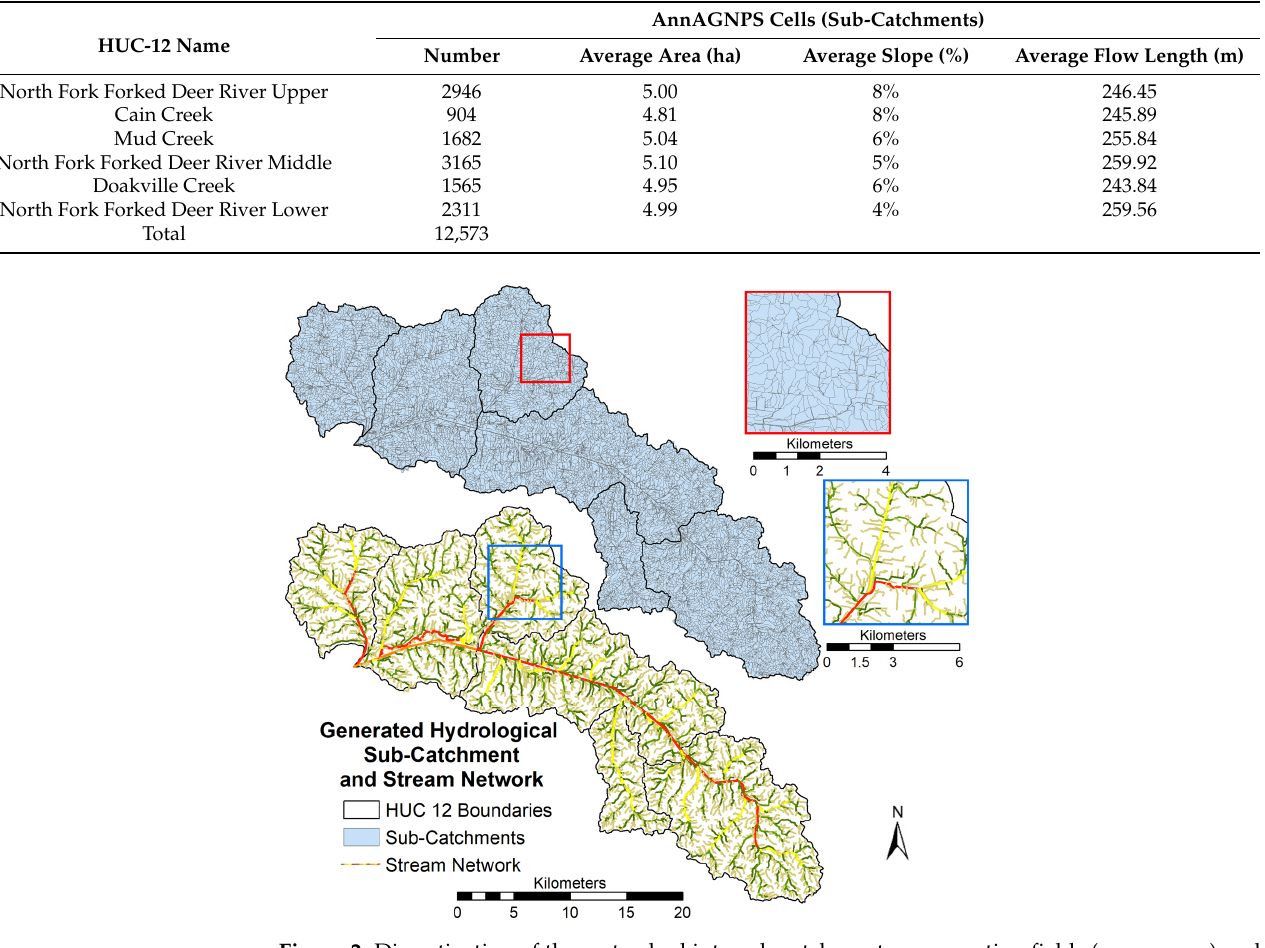
Figure 2. Discretization of the watershed into sub-catchments representing fields (upper map) and reaches representing concentrated flow (lower map).